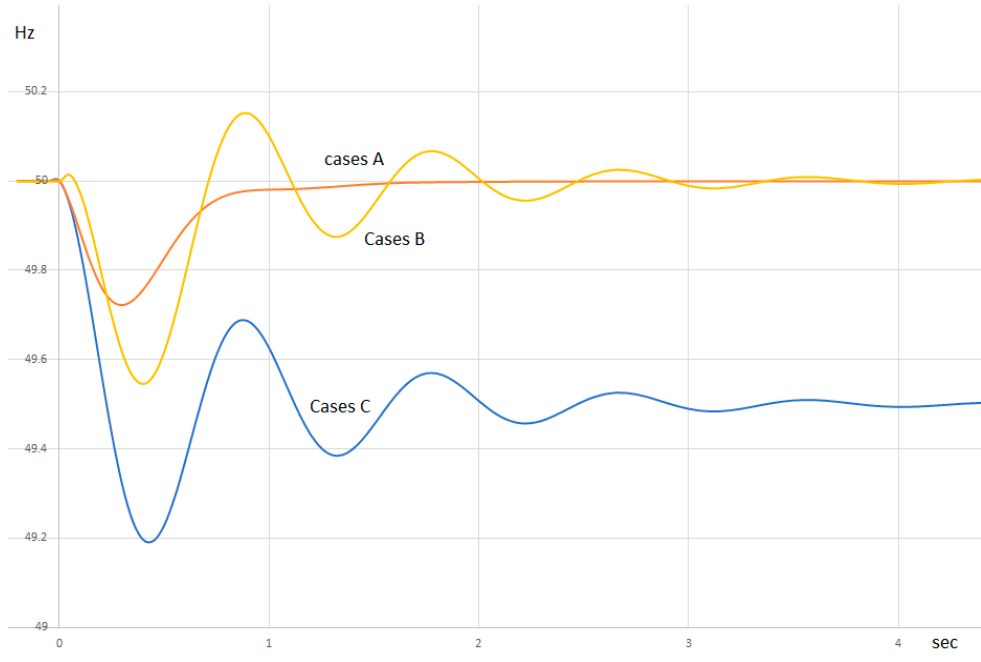
Figure 7. Frequency variations.